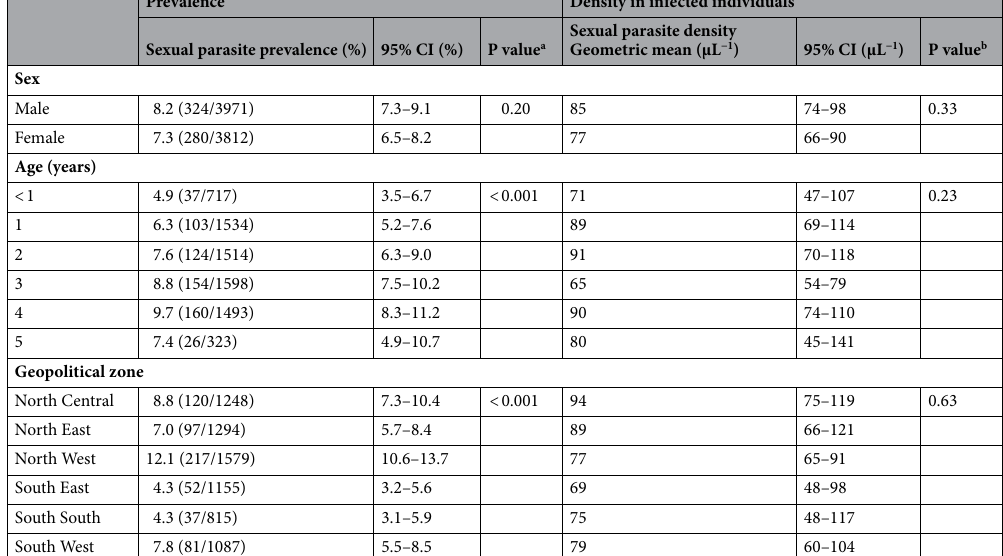
Table 2. Sexual parasite prevalence and density according to sex, age and geopolitical zone in 7783 children up to 5 years of age with complete microscopy data for all variables. a Pearson’s chi squared test. b Mann– Whitney or Kruskal–Wallis